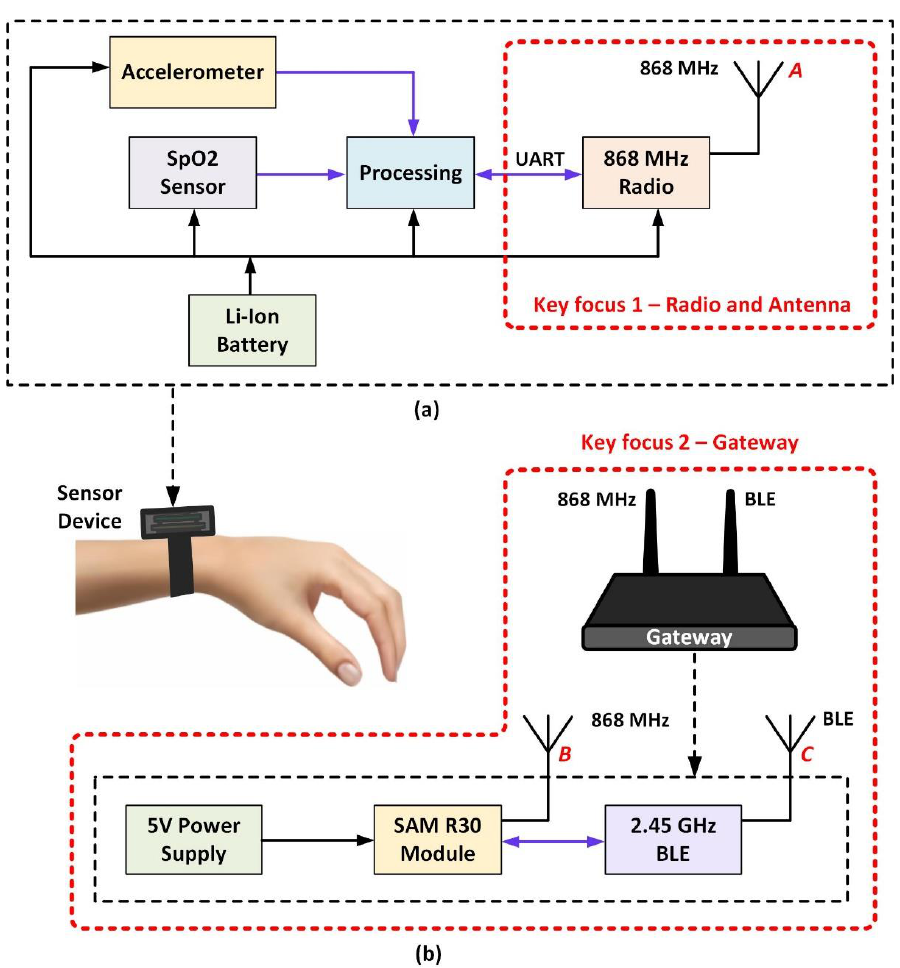
Figure 3. Internal sub-systems of the ( a ) wristwatch sensor device, ( b ) gateway.